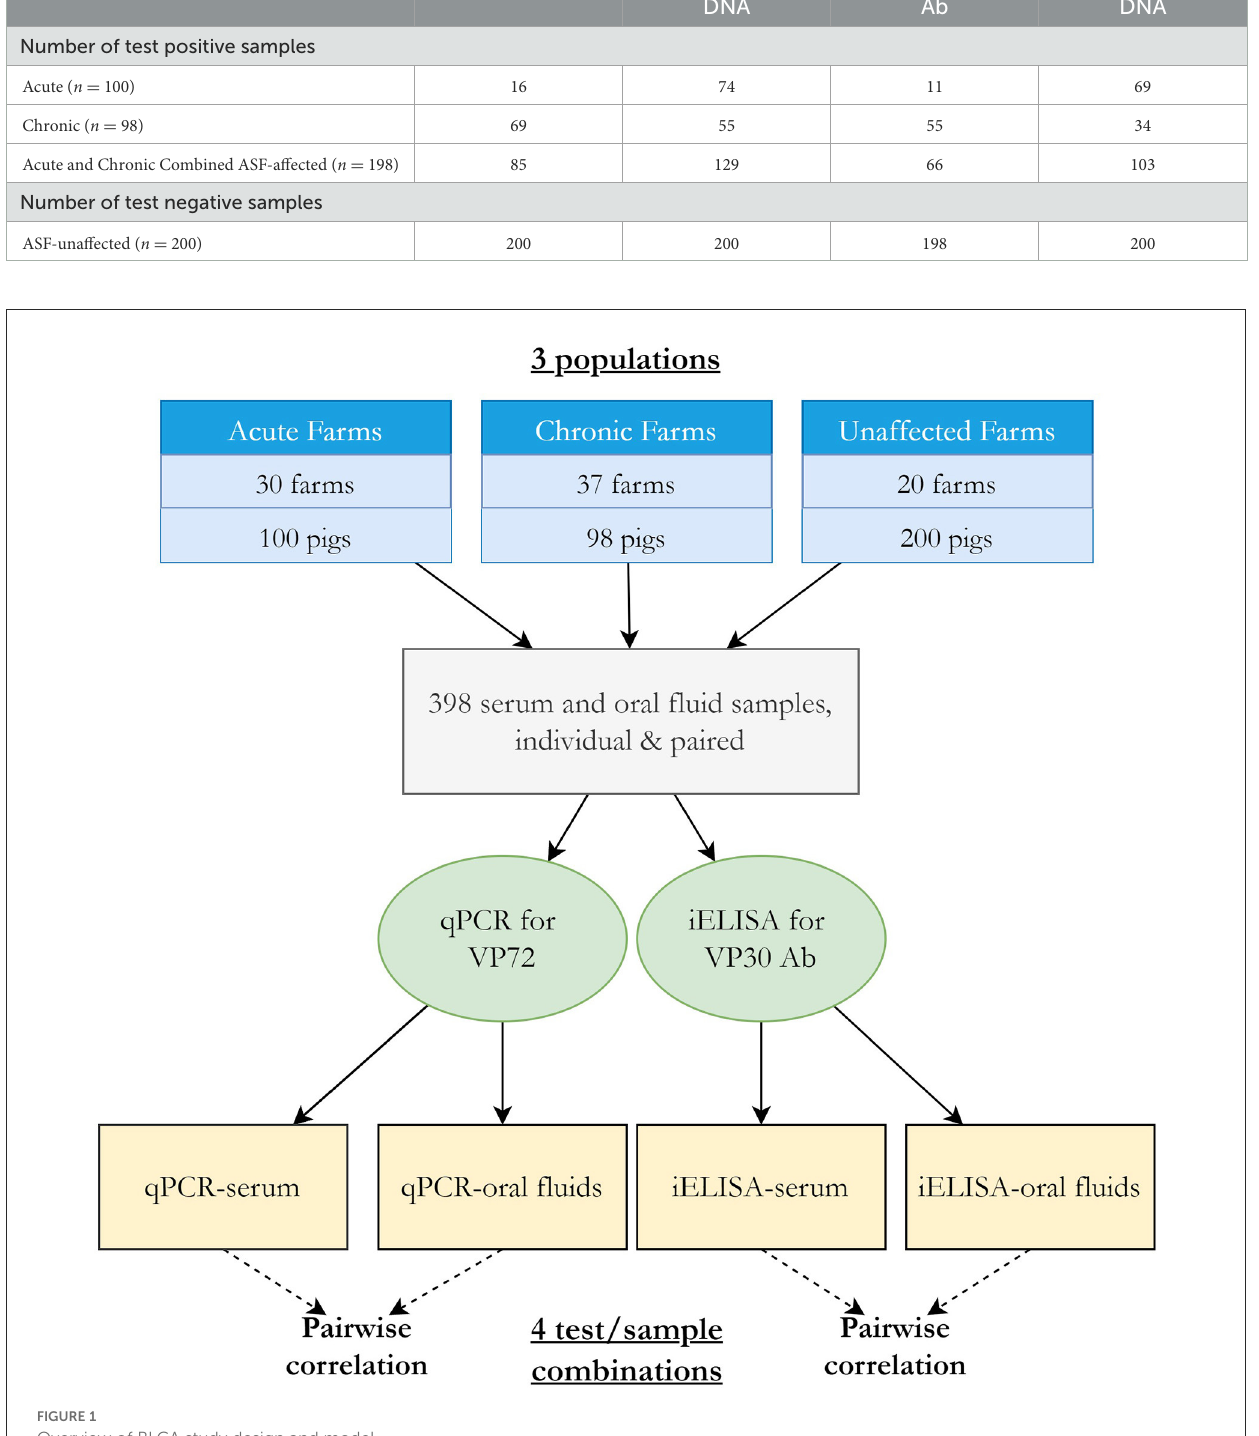
TABLE 1 Number of correctly classified test results using iELISA serum and oral fluid (OF) antibody tests and qPCR serum and OF DNA tests under the assumption that all samples from acute and chronically affected farms are ASF-positive and all samples from unaffected farms are ASF-negative.